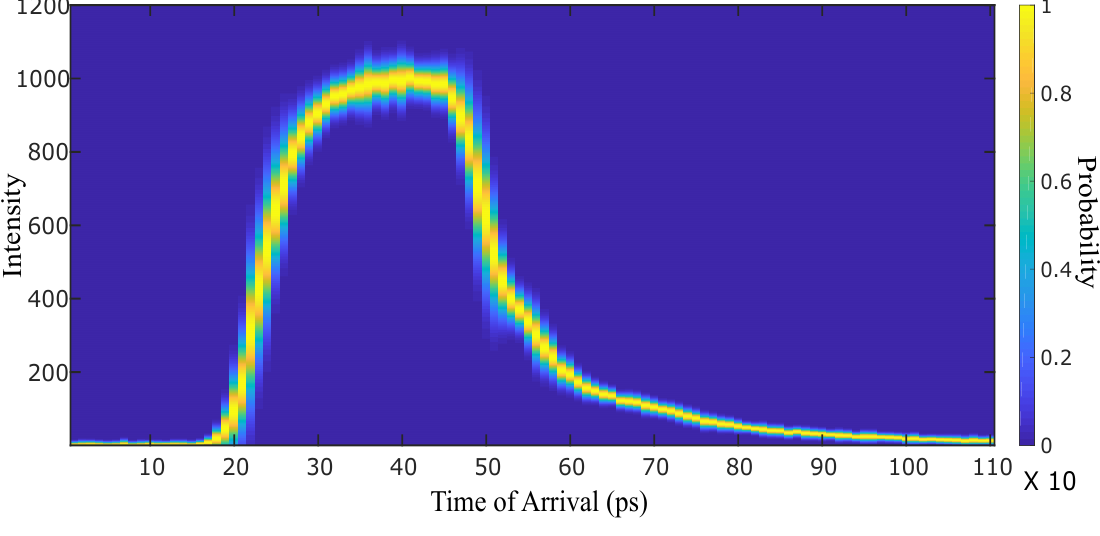
Figure 3. Estimation of the camera temporal response and jitter. Given a specific intensity value on the rising or falling edge, the most likely time of arrival can be obtained to within the standard deviation of the curve (i.e., the full width of the curve thickness) that is 10 ps for our ICCD